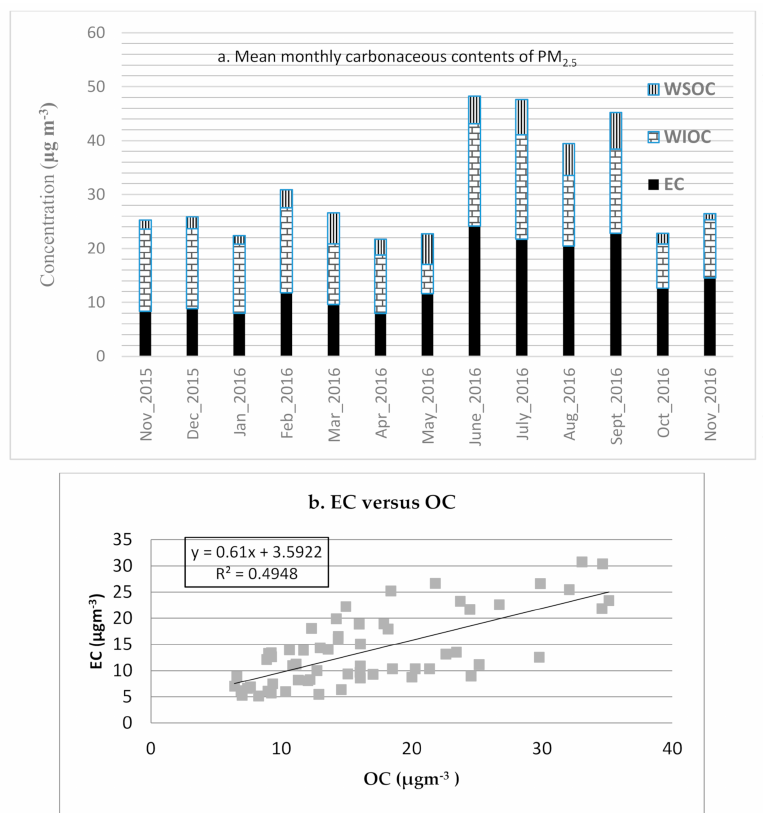
Figure 2. ( a ) Carbonaceous contents of PM 2.5 in central Addis Ababa, October 2015–December 2016. ( b ) Scatter plot of OC versus EC concentrations of PM 2.5 in central Addis Ababa, October 2015–December 2016. N.B.: 24-December 2015; 16-May; 9-June, 15-June; and 3-July 2016 were missing data due to various reasons (including power outages), not days with zero values. Extreme values during 10-May, 19-September, and 25-September 2016 were excluded (not shown on Figure 2a as data aggregation to